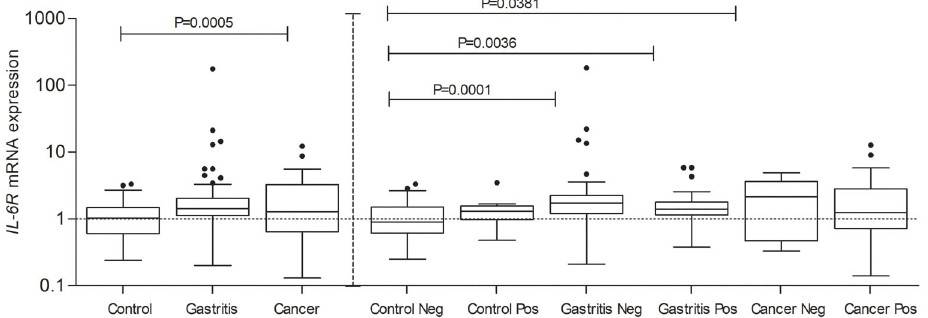
Figure 2. Analysis of interleukin-6 receptor ( IL-6R ) expression (percent of Control) in Control, Gastritis, and Cancer groups when the presence of H. pylori was not considered ( left ), and when it was considered ( right ). Data are reported as medians and interquartile range (ANOVA). Control neg and pos: normal gastric tissue without gastritis or in fl ammatory process and negative or positive for H. pylori infection; Gastritis neg and pos: patients with gastritis and negative or positive for H. pylori ; Cancer neg or pos: patients with cancer and negative or positive for H. pylori .